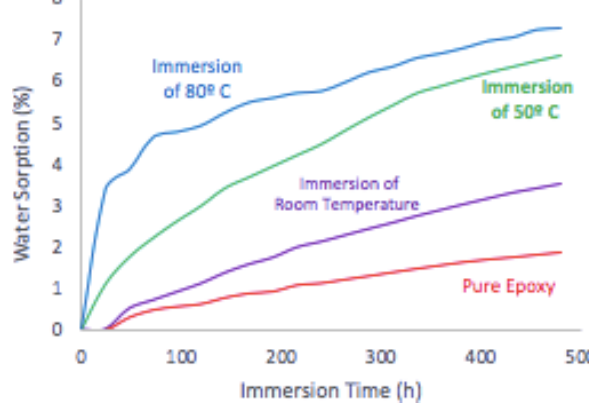
Figure 2: Water Sorption Behaviour of Bamboo-Epoxy Composites in Various Immersion